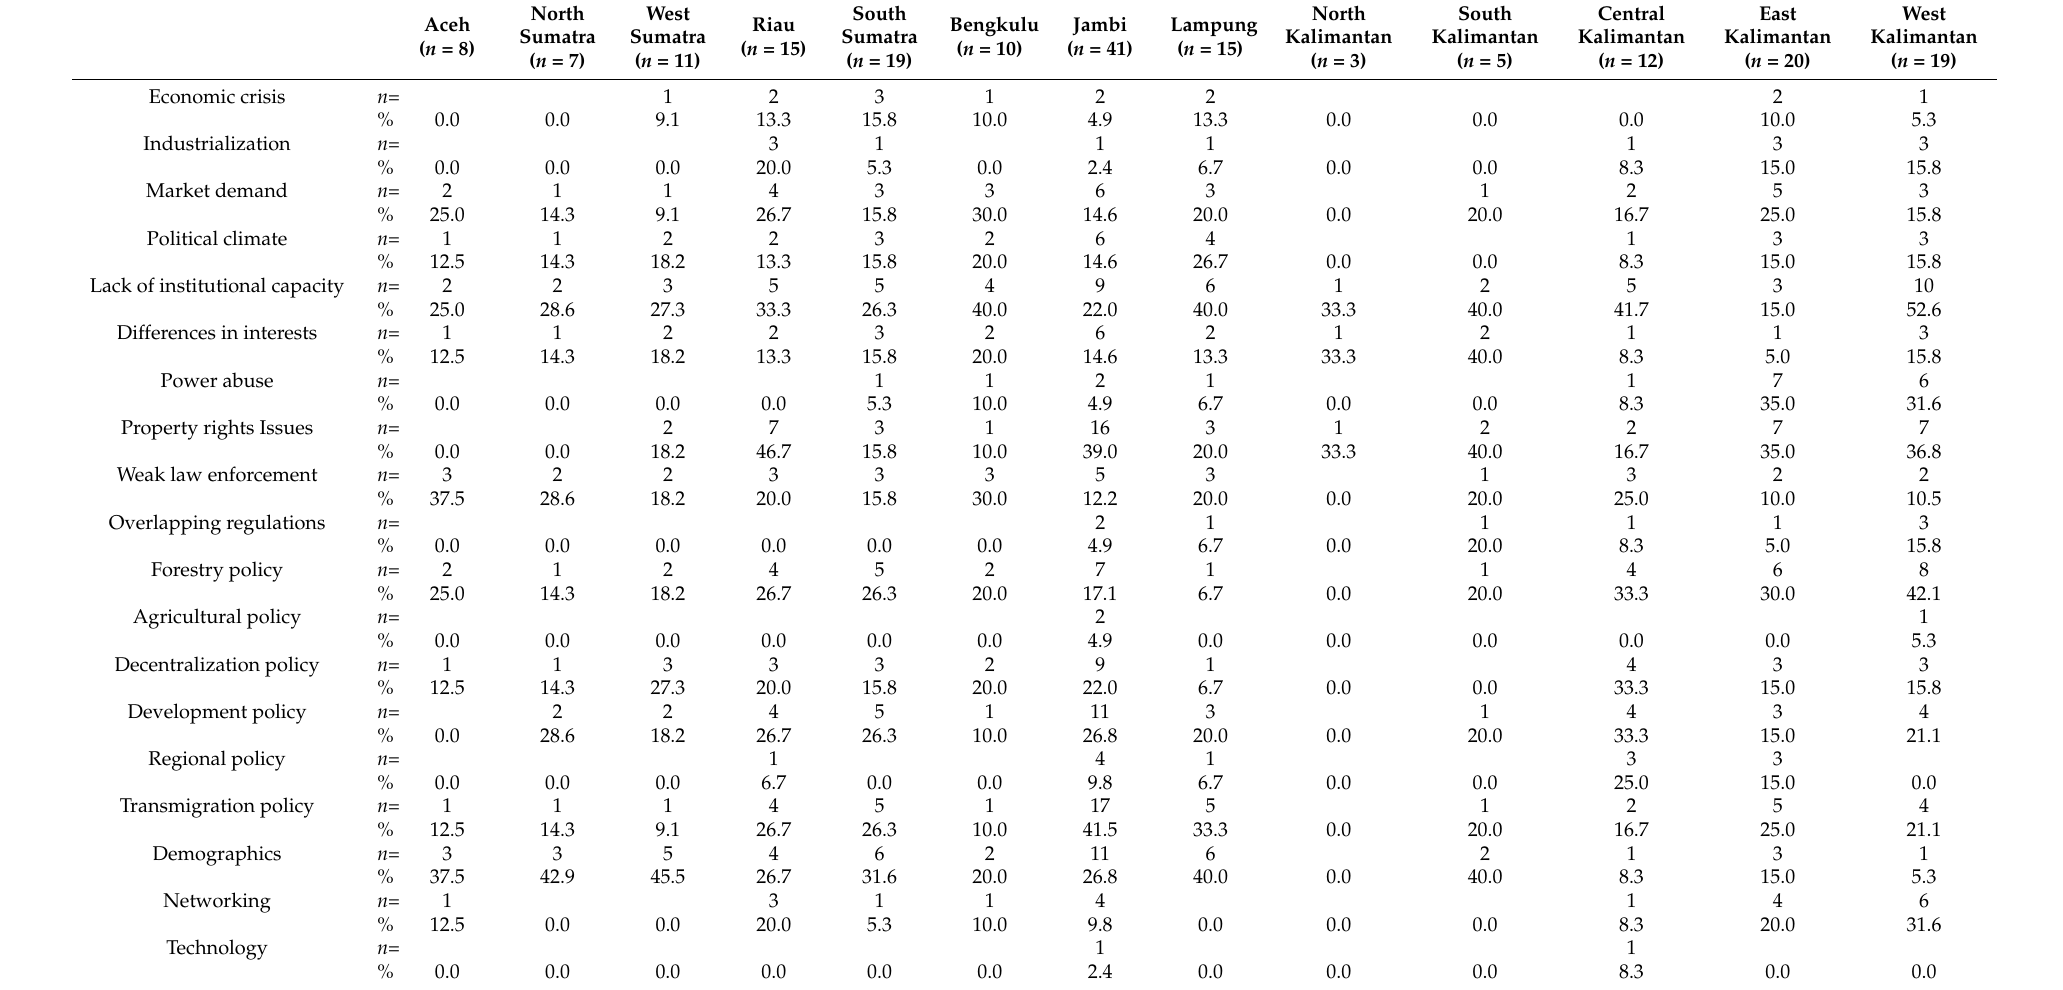
Table A6. Frequency of underlying causes of land change in Sumatra and